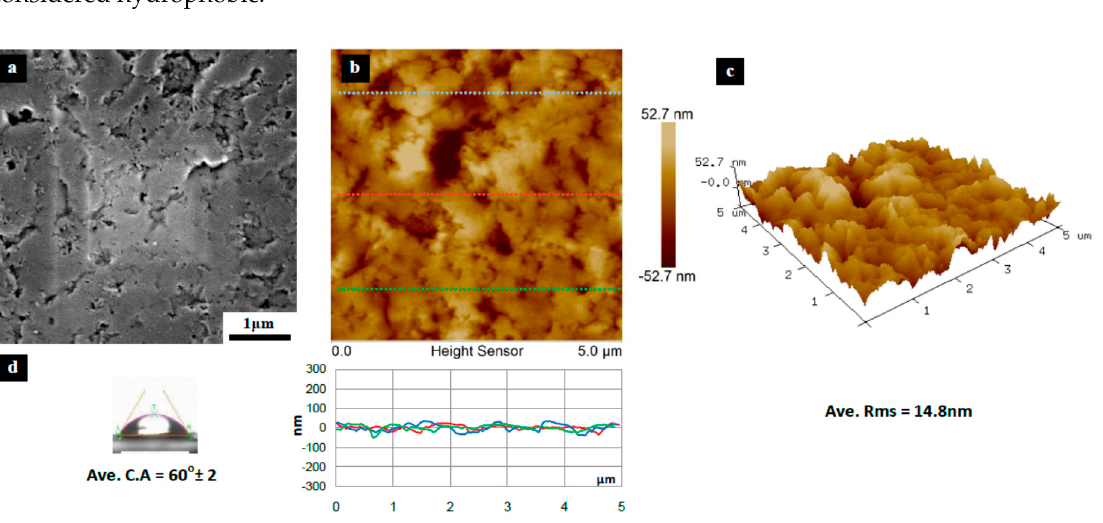
Figure 7. Surface characteristics of as received PVDF 3 substrate (10 nm pore size), ( a ) SEM